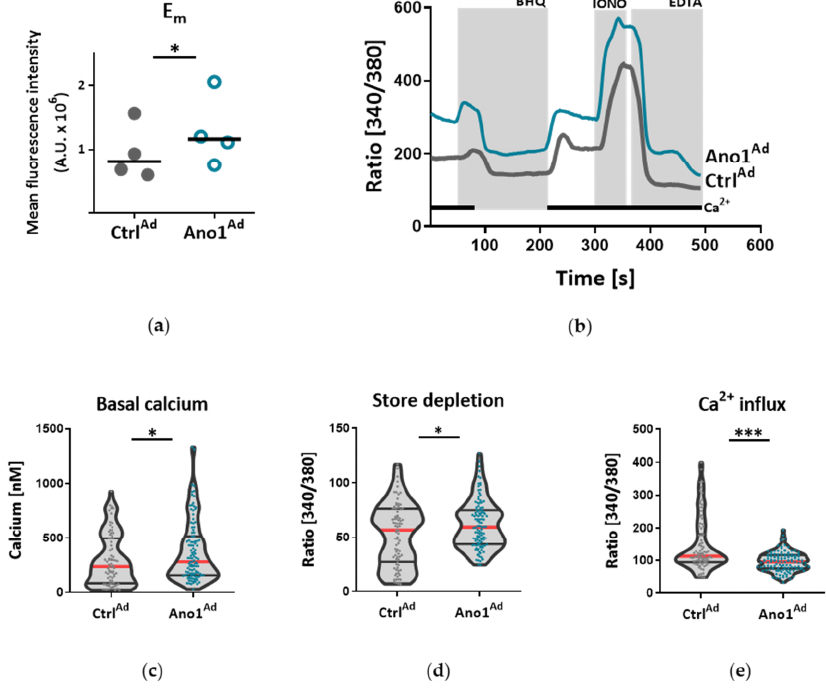
Figure 3. Upregulation of TMEM16A in human PAECs. ( a ) Immunofluorescence staining of TMEM16A in PAECs infected with Ctrl Ad or Ano1 Ad (BP = antibody blocking peptide; scale bar = 20 μm). ( b ) Representative whole-cell I ClCa traces (left) and normalized current-voltage relationships (right) measured with voltage-clamp showing the effect of Bbr in donor PAECs transfected with Ctrl Ad . ( c ) Representative whole-cell I ClCa traces (left) and normalized current-voltage relationships (right) measured with voltage-clamp showing the effect of Bbr in donor PAECs transfected with Ano1 Ad and overexpressing TMEM16A. ( d ) Consecutive, calculated Bbr-sensitive current comparing primary PAECs infected with Ctrl Ad or Ano1 Ad . Figures were generated with 8–13 cells from N = 2 healthy donors, data are presented as mean ± s.e.m.